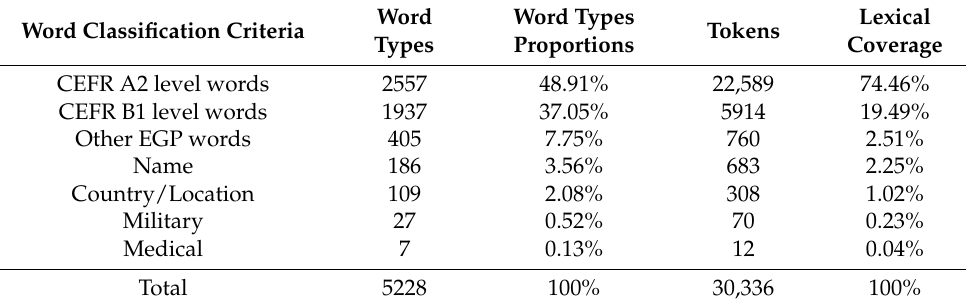
Table 2. Lexical composition of the target corpus (removing the function